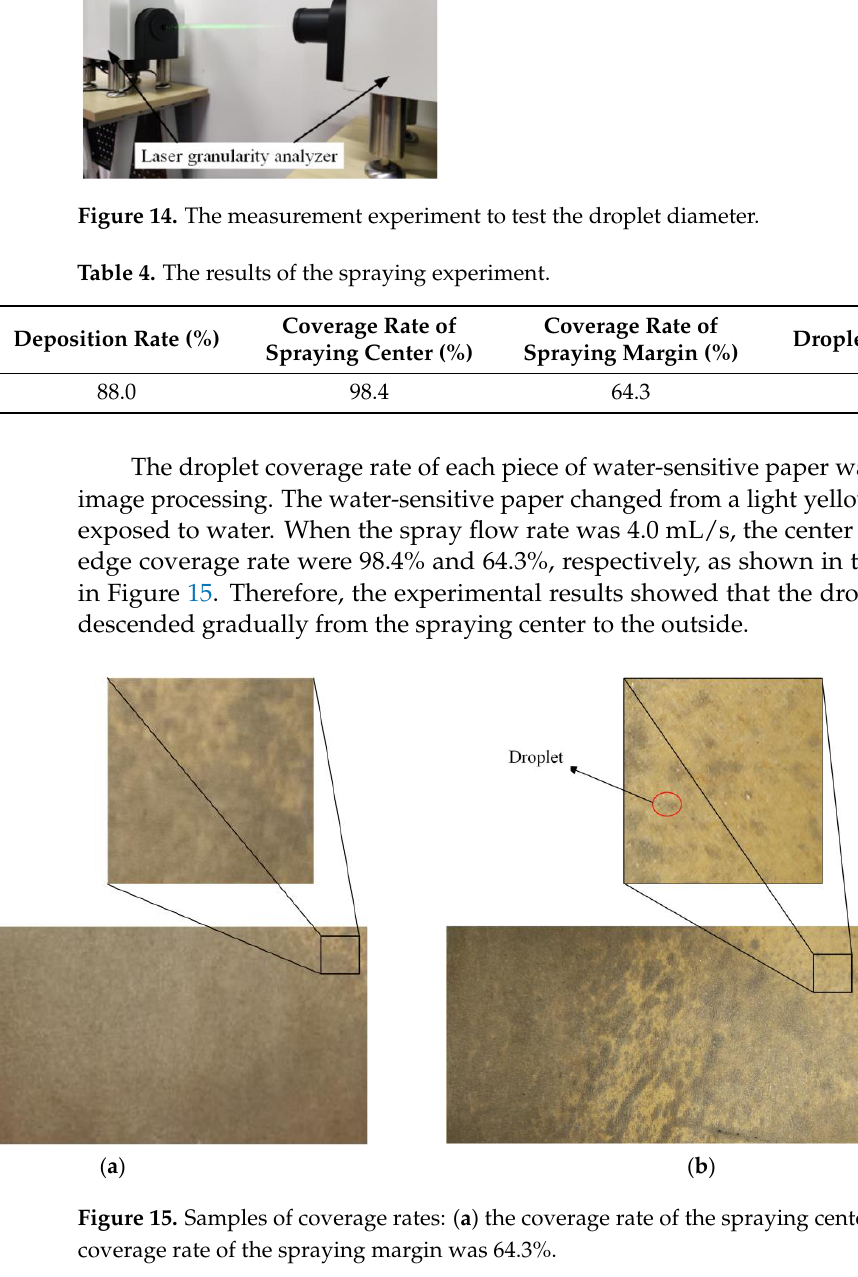
( c ) Figure 13. The three states of the spray manipulator in spraying operations: ( a ) initial state of the spray manipulator; ( b ) spraying state of the spray manipulator for target 1; ( c ) spraying state of the spray manipulator for target 2.